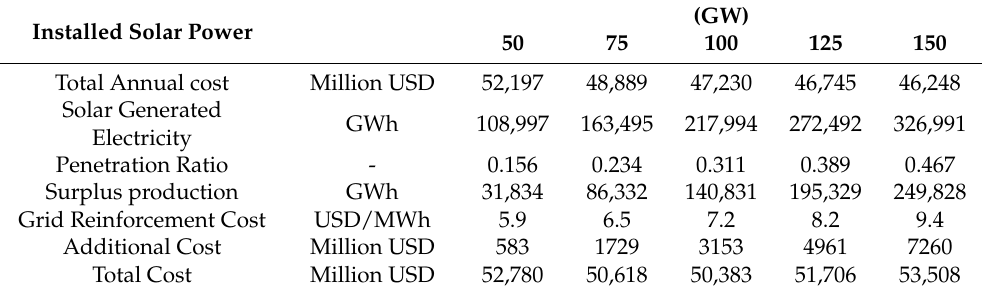
Table 12. Variation of the total cost for the solar capacity with the addition of the grid integration